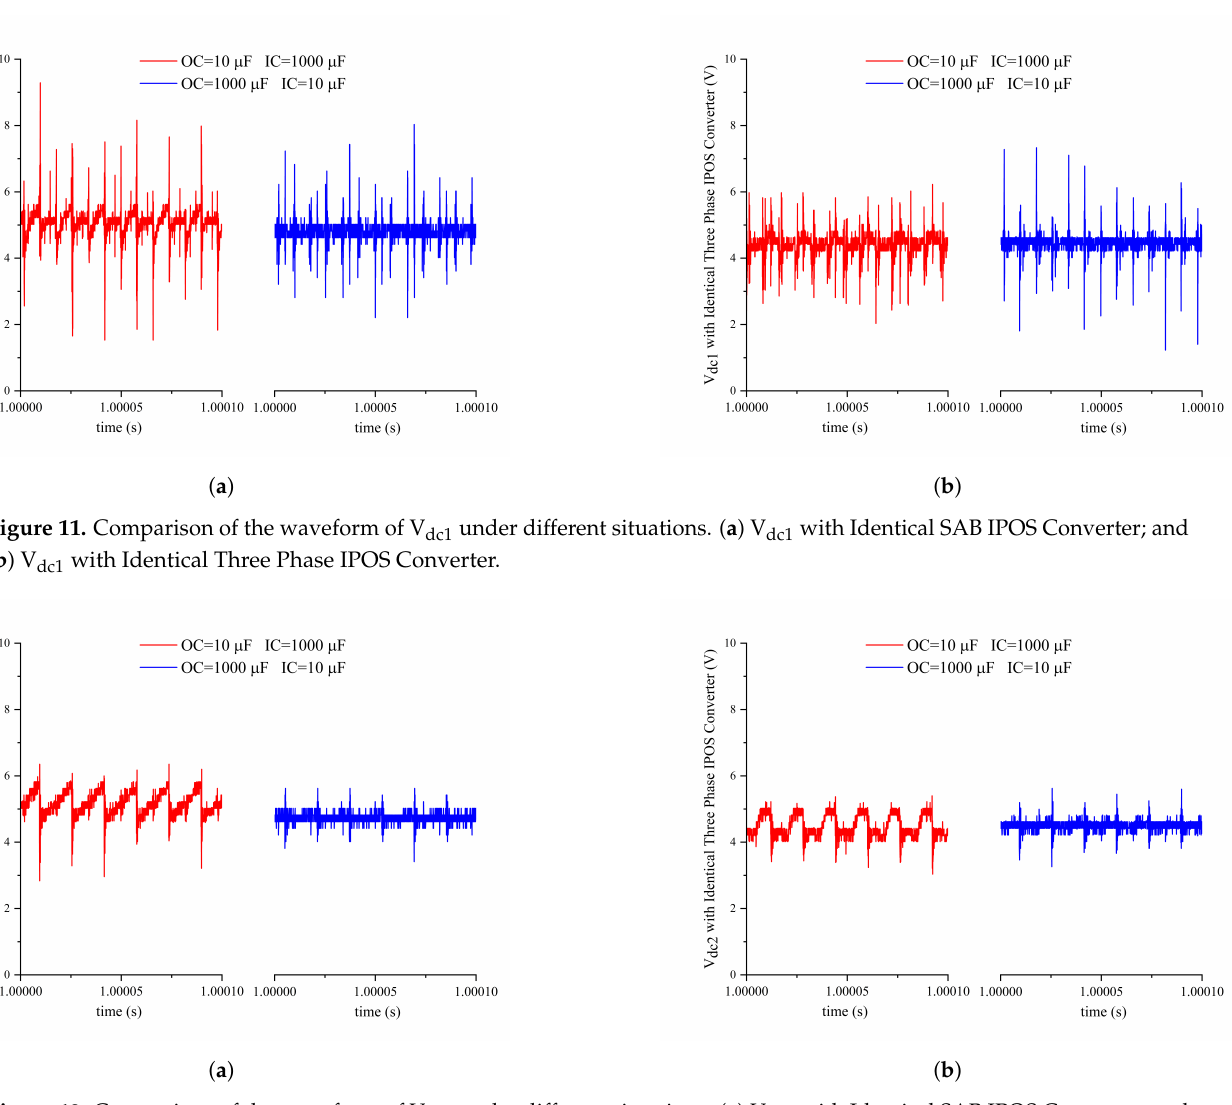
Figure 12. Comparison of the waveform of V dc2 under different situations. ( a ) V dc2 with Identical SAB IPOS Converter; and ( b ) V dc2 with Identical Three Phase IPOS